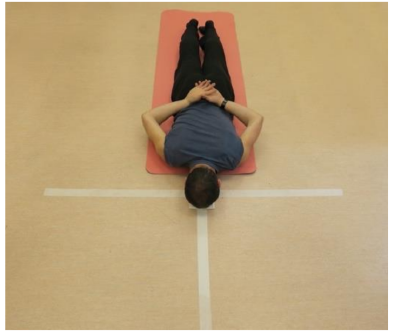
Figure 3. The preparation of the participant before the consecutive series of